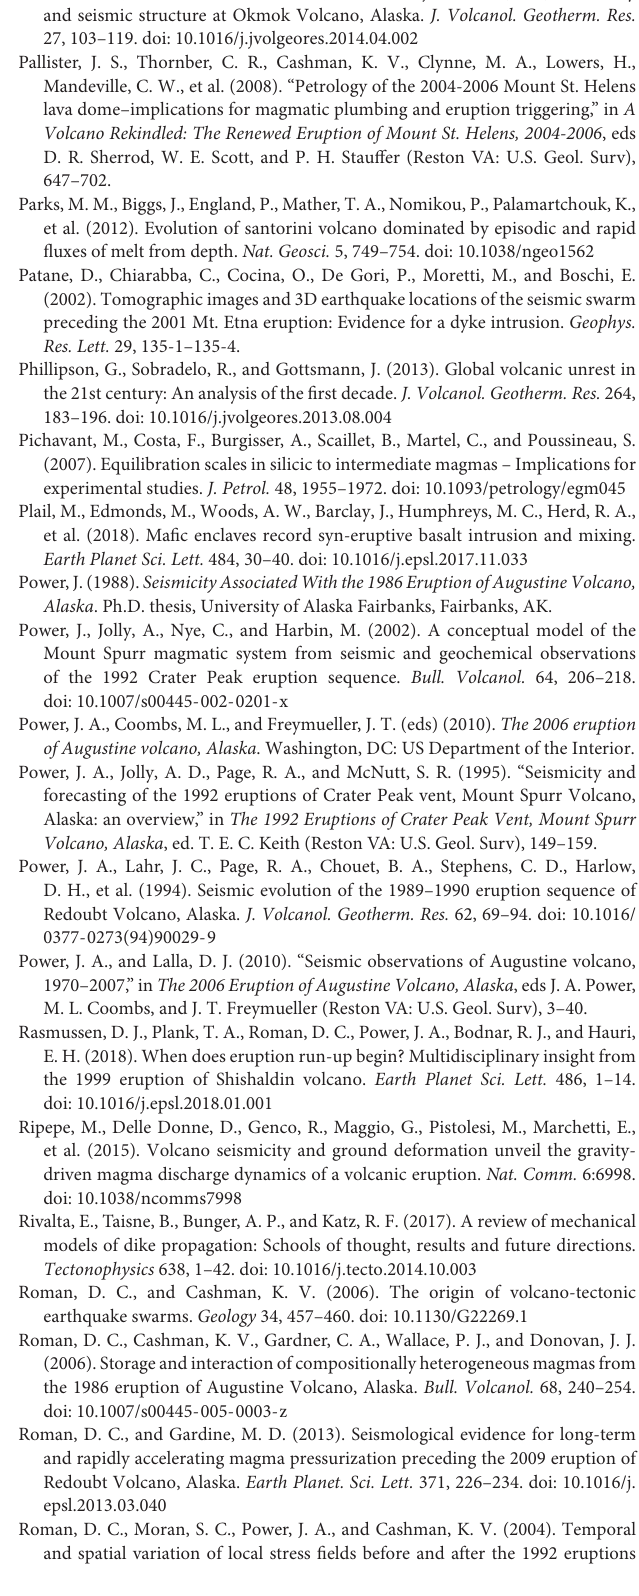
and spatial variation of local stress fields before and after the 1992 eruptions